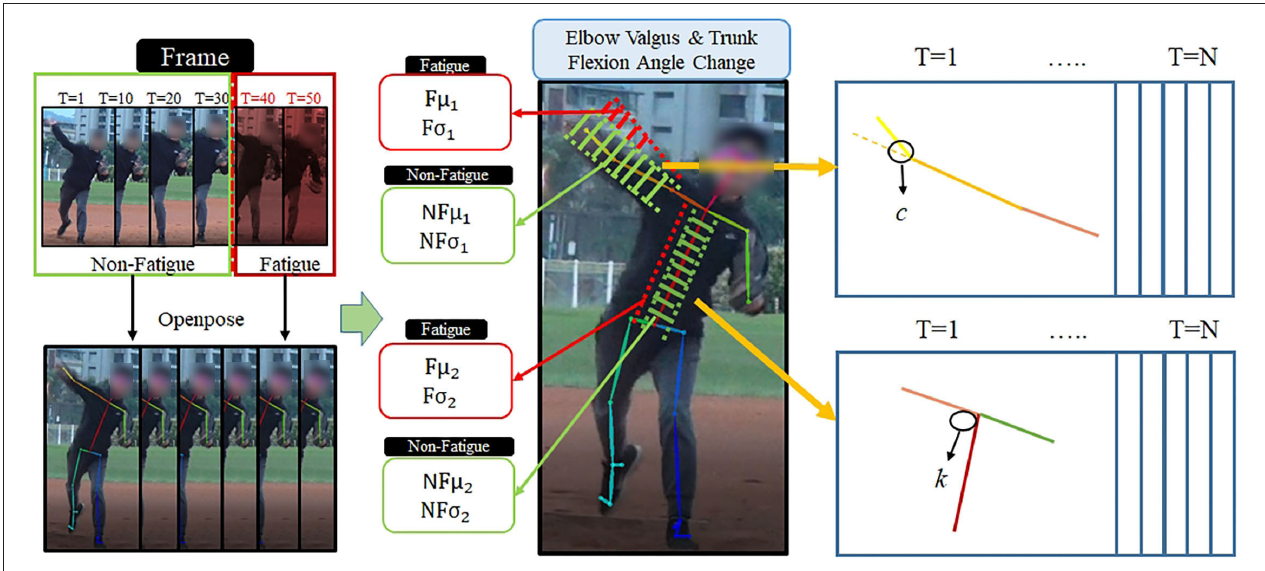
FIGURE 1 | Elbow valgus and trunk flexion angle analysis